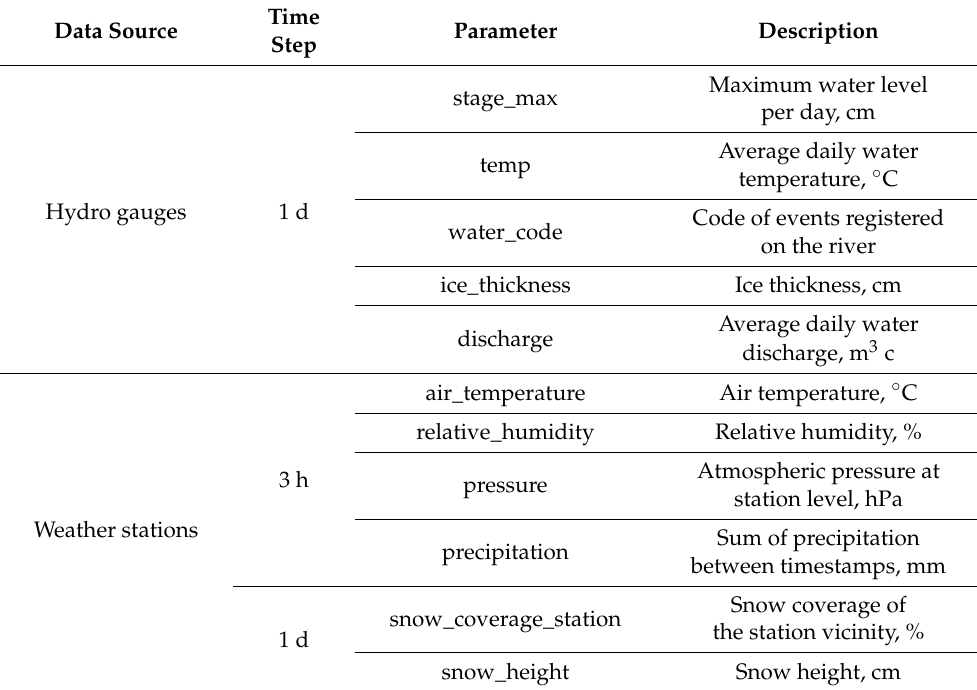
Table 2. Data sources and parameters that were used for fitting and validation of the